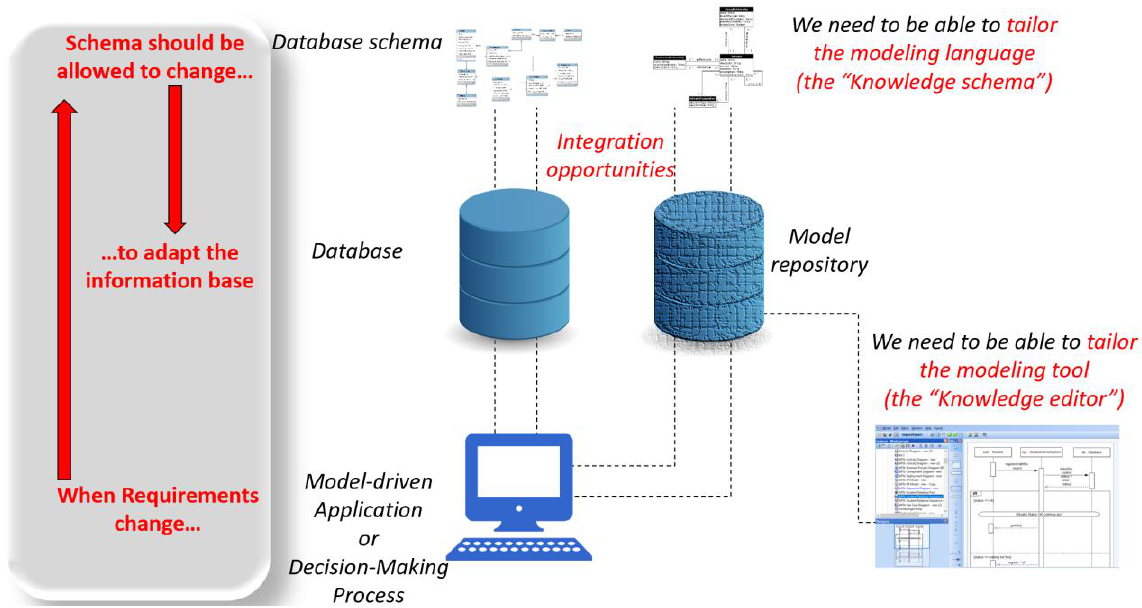
Figure 1. The Database/Model repository analogy as rationale for agility in modeling